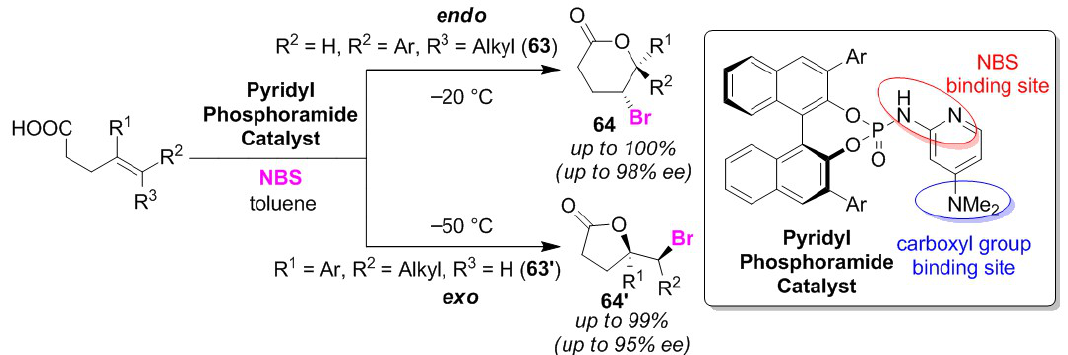
Figure 31. Endo / exo selective bromo-lactonizations of disubstituted olefinic acids ( 63 and 63 (cid:48) ) using a pyridyl phosphoramide catalyst.